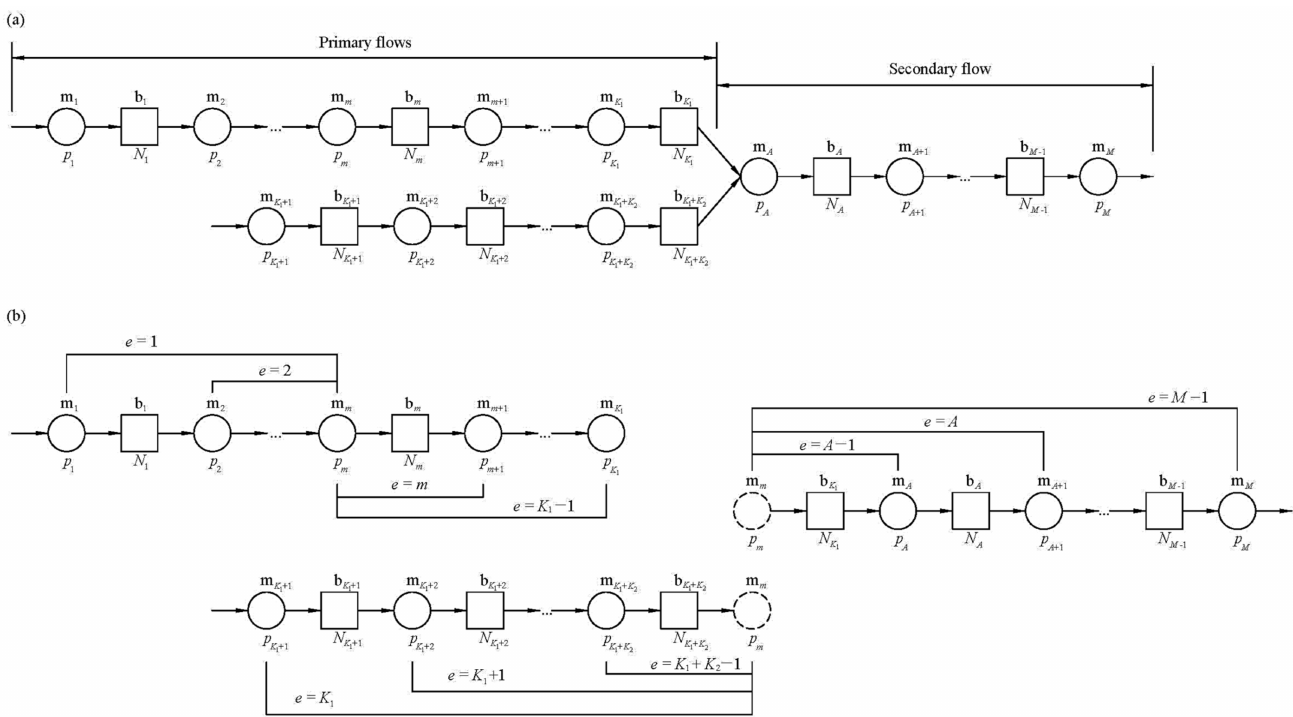
Figure 3. Structure of the finite state elements in the case of an assembly production line: ( a ) Definition of primary and secondary flows; ( b ) formulation of